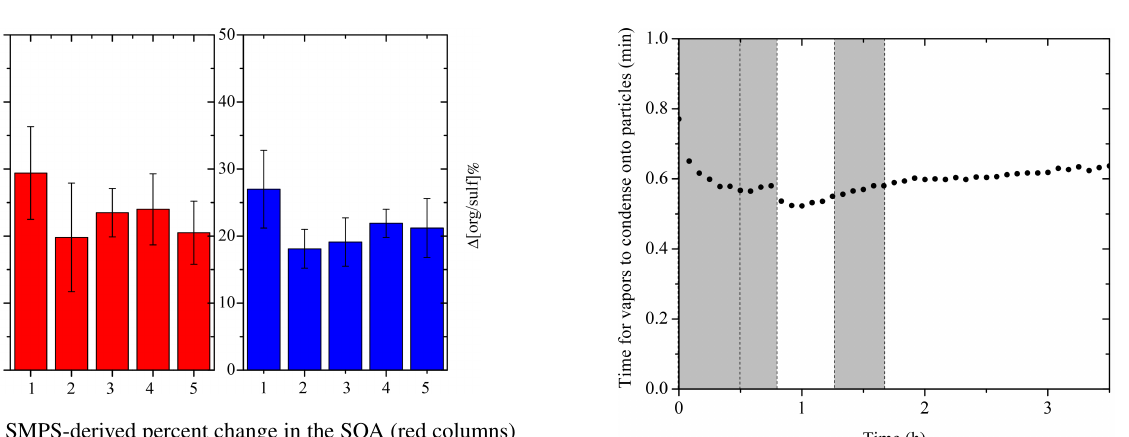
Figure 8. SMPS-derived percent change in the SOA (red columns) mass concentration corrected for particle wall loss after aging and AMS-derived percent change in organic-to-sulfate ratio (blue columns) after aging for all five experiments.